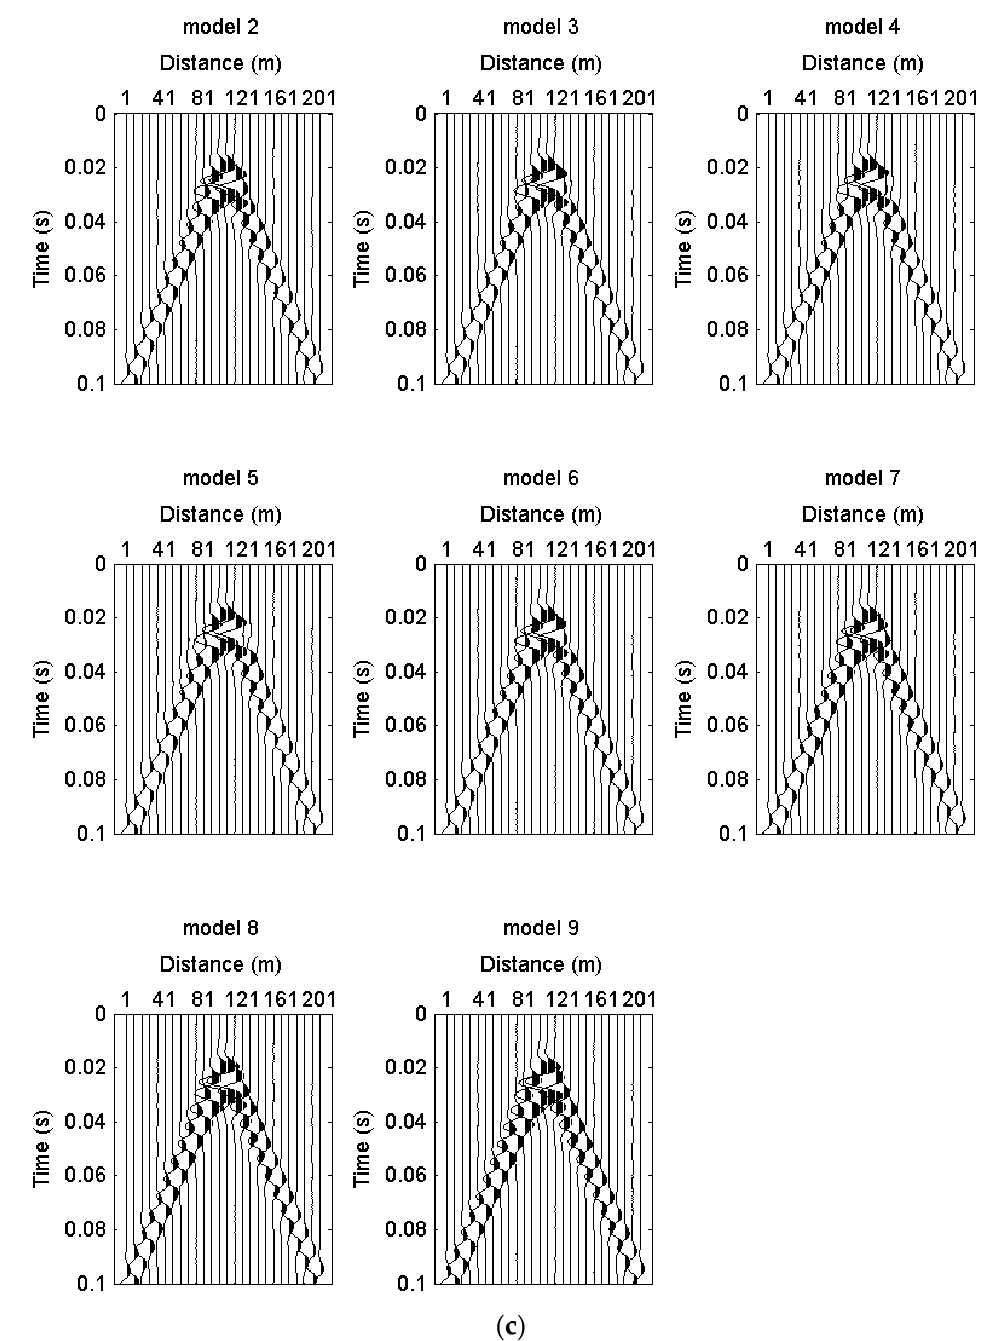
Figure 13. Seismograms. ( a ) Radial concentrated force source. ( b ) Vertical concentrated force source. ( c ) Shear source.